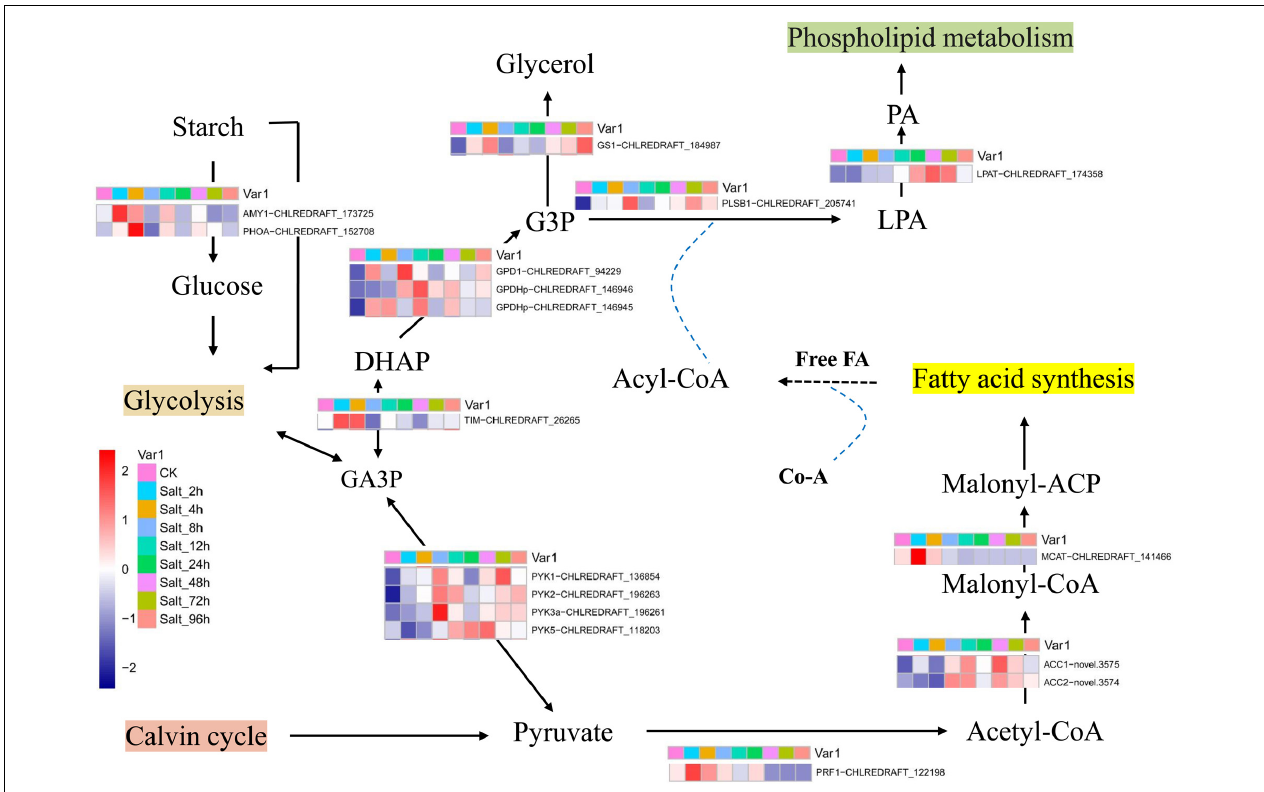
FIGURE 5 | The schematic diagram of starch metabolism, glycerol production, and lipid synthesis. GA3P, glyceraldehyde3-phosphate; G3P, glycerol-3-phosphate; DHAP, dihydroxyacetone phosphate; LPA, lysophosphatidic acid; PA, phosphatidic acid. Mean FPKM values of the three samples in each time point were used as representative of genes’ expression value in eight salt-treated time points and control